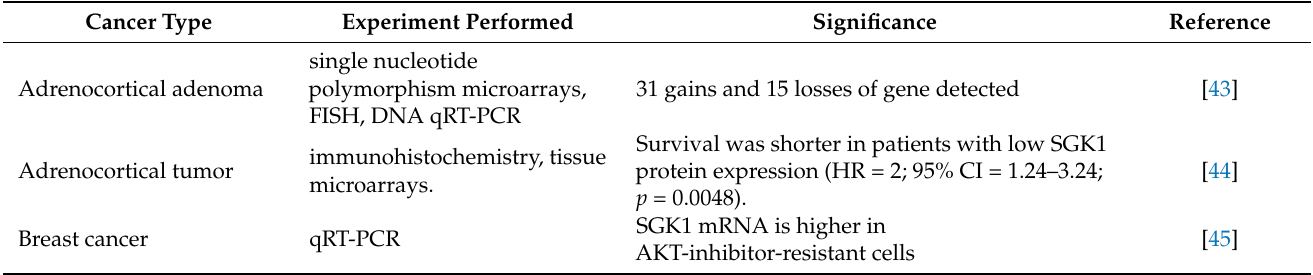
Table 1. Most significant studies on SGK1 biomarker and drug target